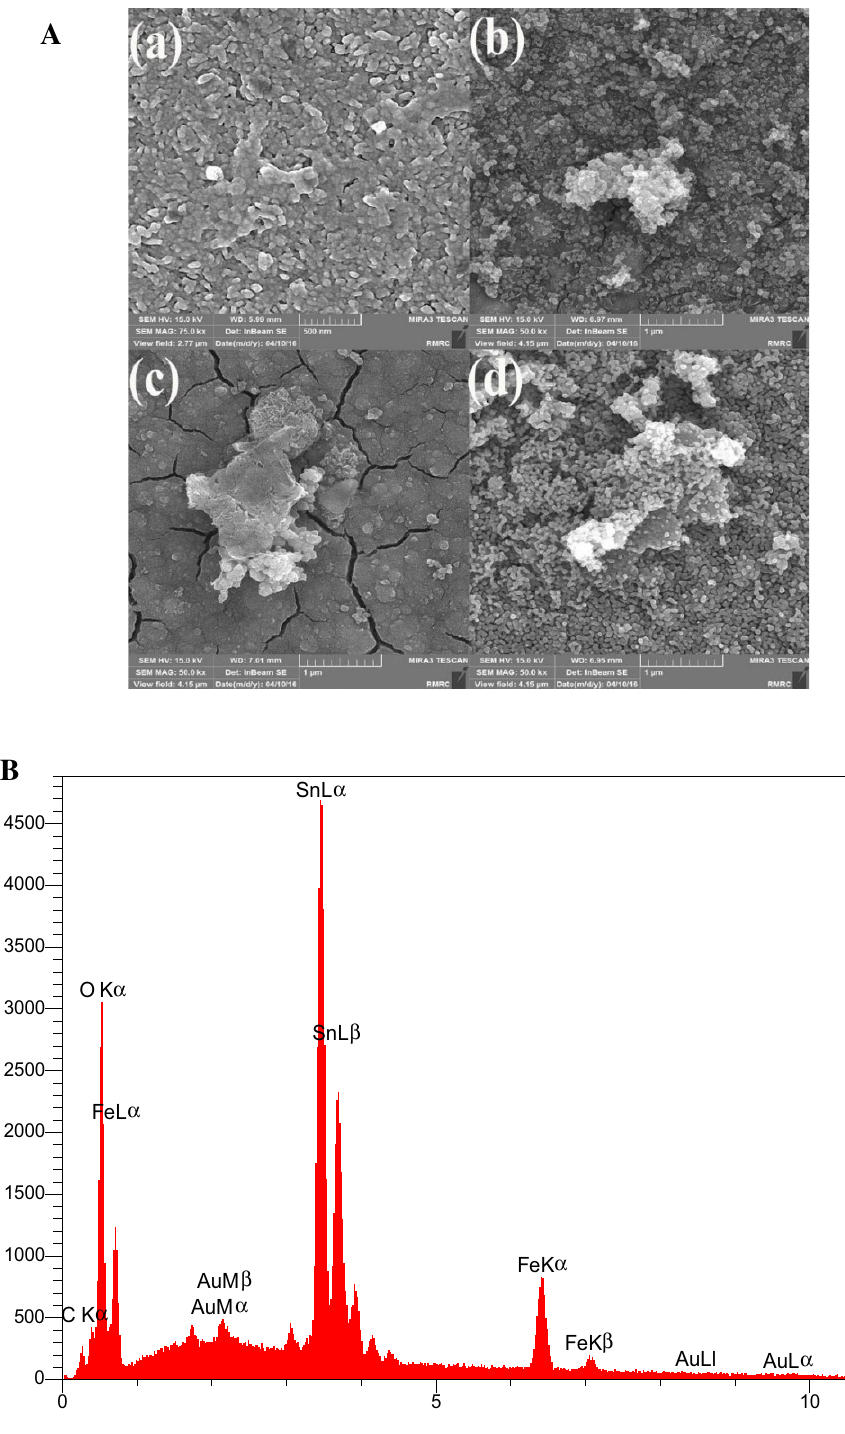
Figure 8. ( A ) FESEM analysis ( a ) Fe2O3-GO annealed at 300 °C ( b ) Fe2O3-GO annealed at 400 °C ( c ) Fe2O3-GO annealed at 500 °C ( d ) Fe2O3-GO annealed at 700 °C and ( B ) FESEM-EDS mapping (annealing at 500 °C) of synthesized thin film